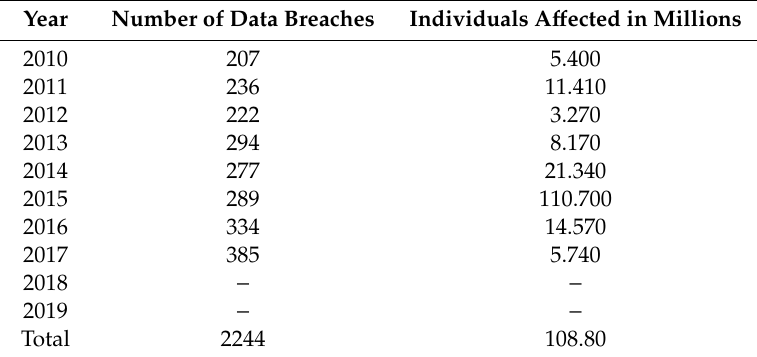
Table 4. Reported Healthcare Data